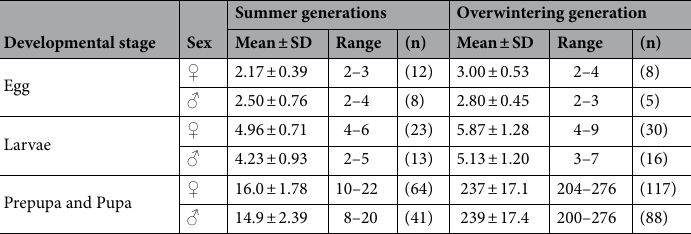
Table 2. The length of each development period of an egg, larva, and prepupa and pupa (day) in the summer and overwintering generations of Dipogon sperconsus.